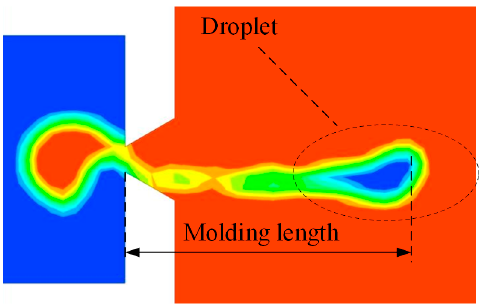
Figure 5. The model for the calculation of the volume and tail length of a droplet.